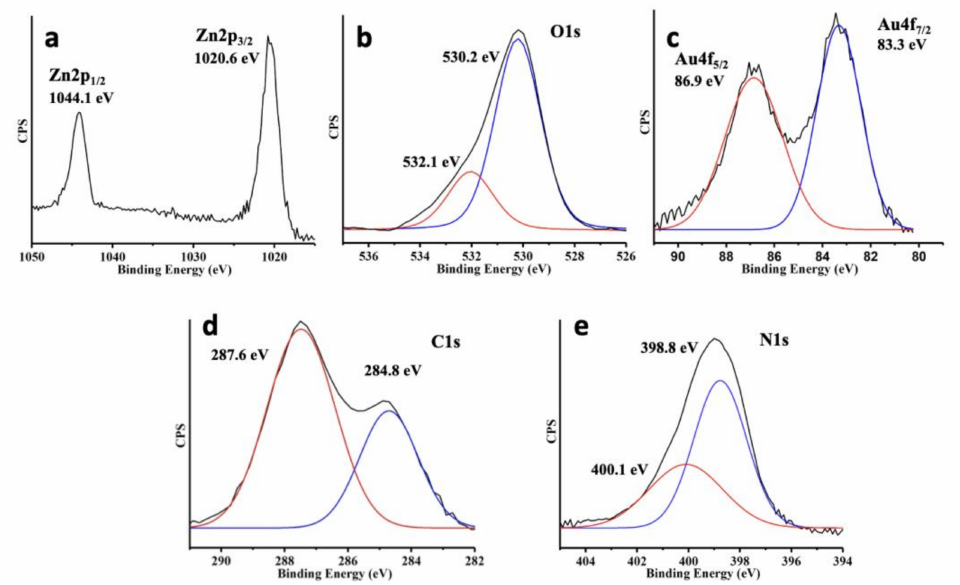
Figure 6. ( a ) XPS core level spectra for 10%Au@ZnONPs-3%rGO-3%gC 3 N 4 : Zn2p; ( b ) O1s; ( c ) Au4f; ( d ) C1s; and ( e )